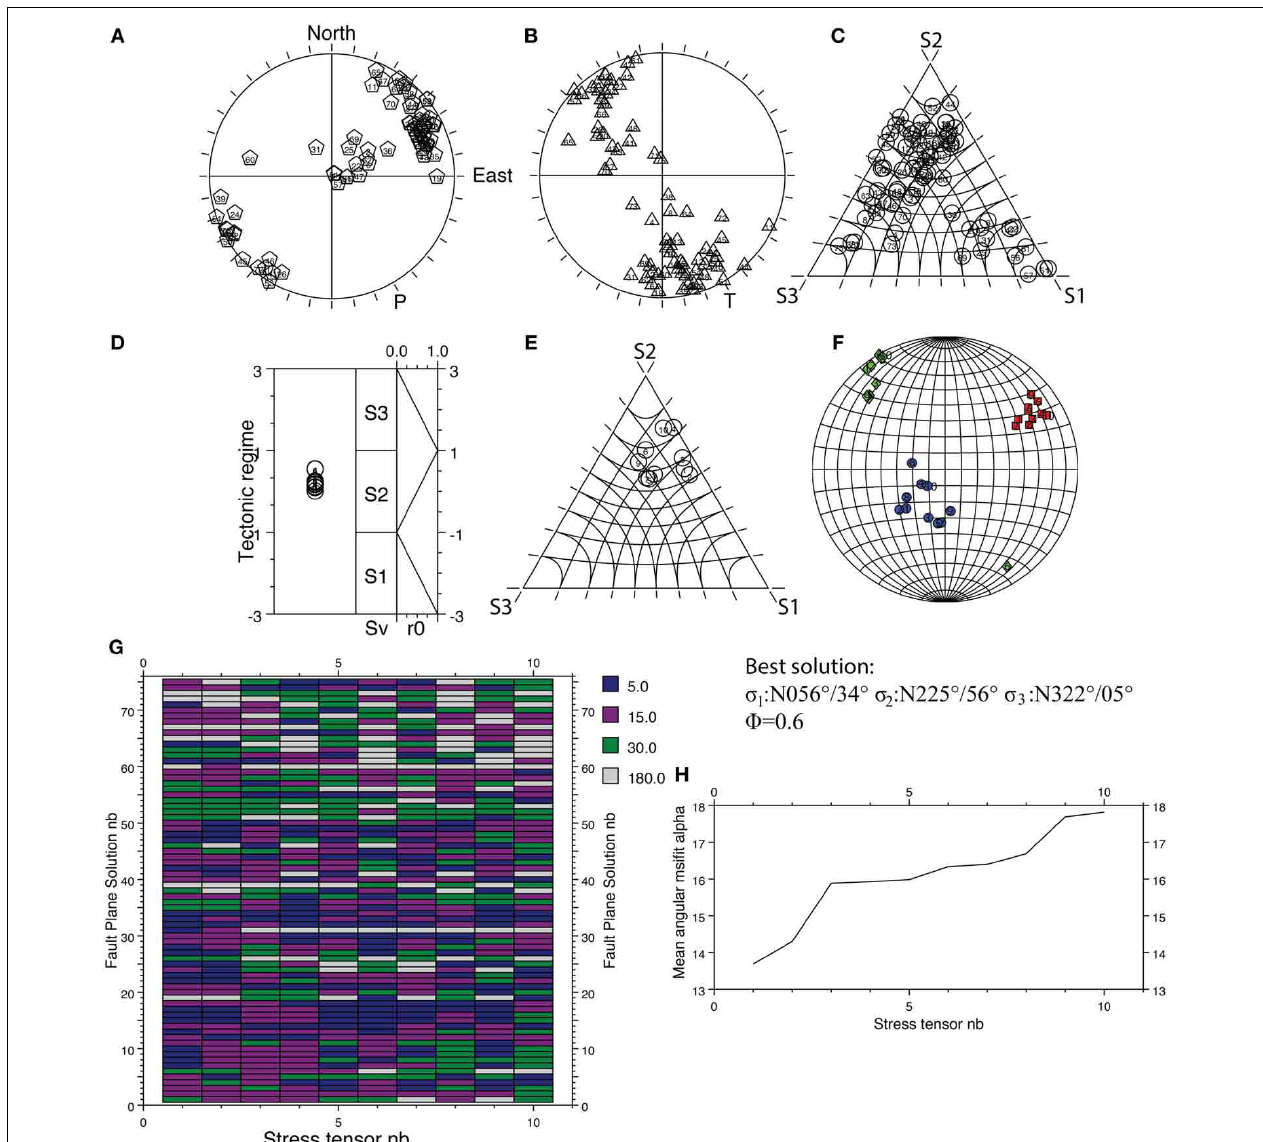
FIGURE 11 | P, B, and T analysis and stress inversion results for the tectonic regime T2. Same legend as Figure 10